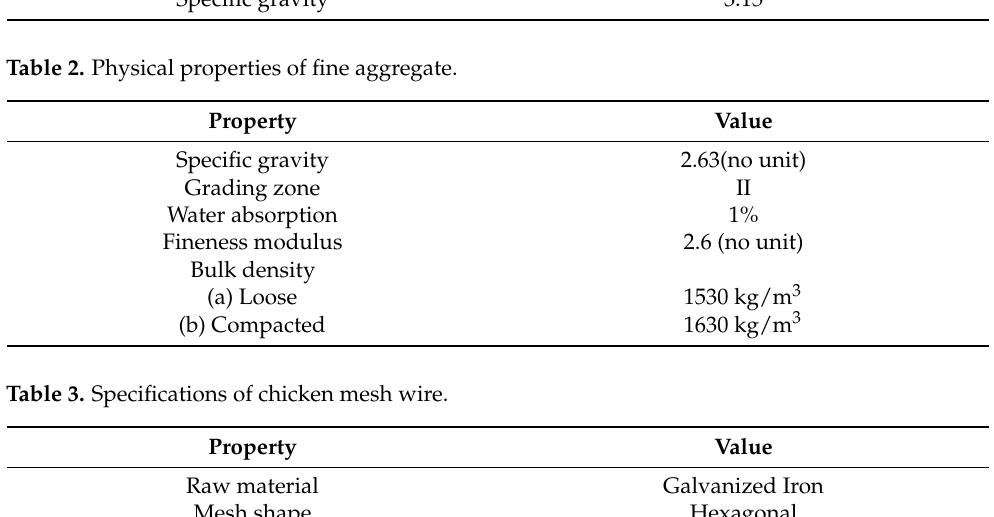
Table 3. Specifications of chicken mesh wire.